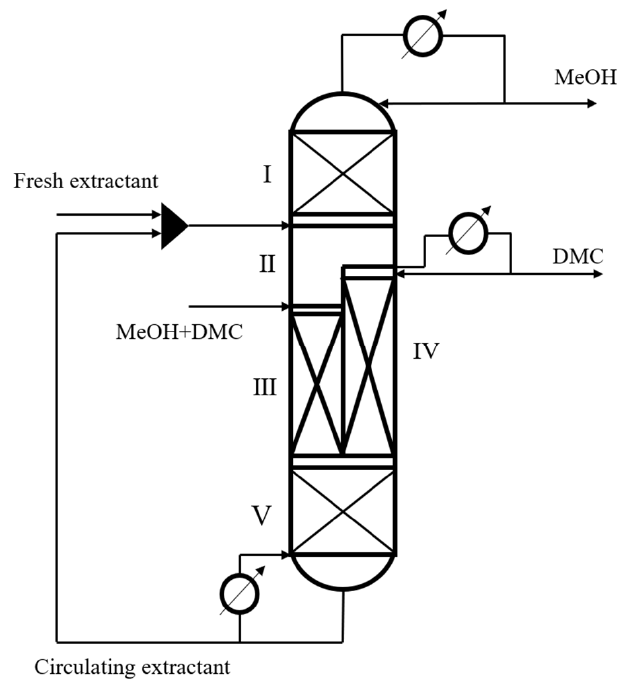
Figure 2. Extractive dividing wall column structure, (I) the extraction agent recovery section; (II) the distillation section; (III) the extractive distillation section; (IV) the side-line distillation section; (V) the extraction and distillation section.